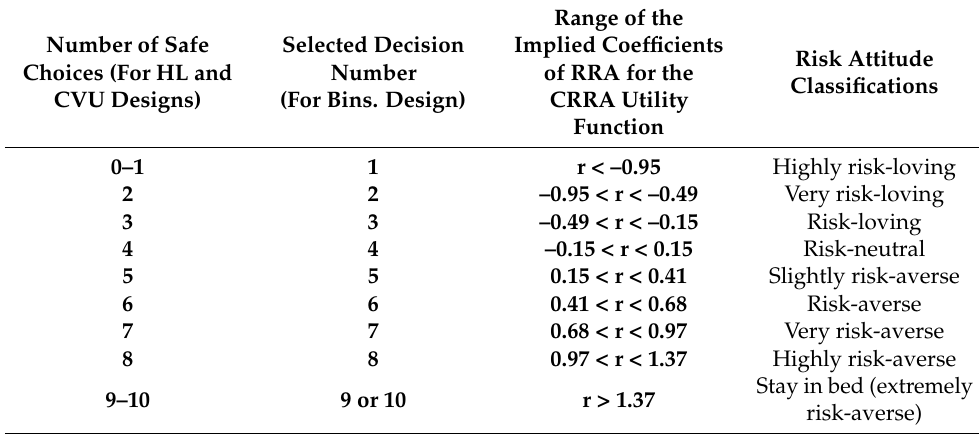
Table A9. Risk aversion classifications based on chosen